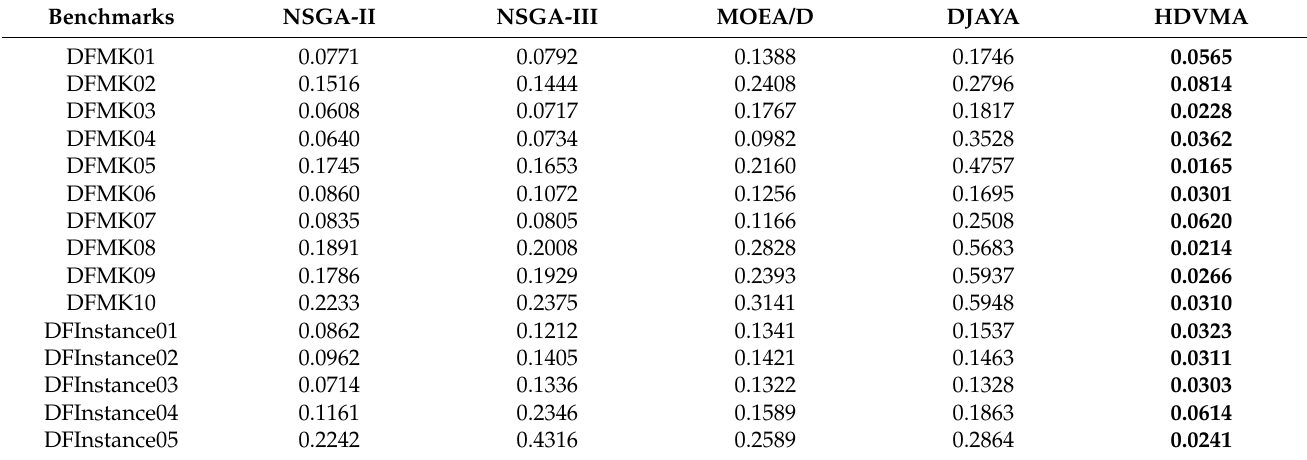
Table 8. IGD value